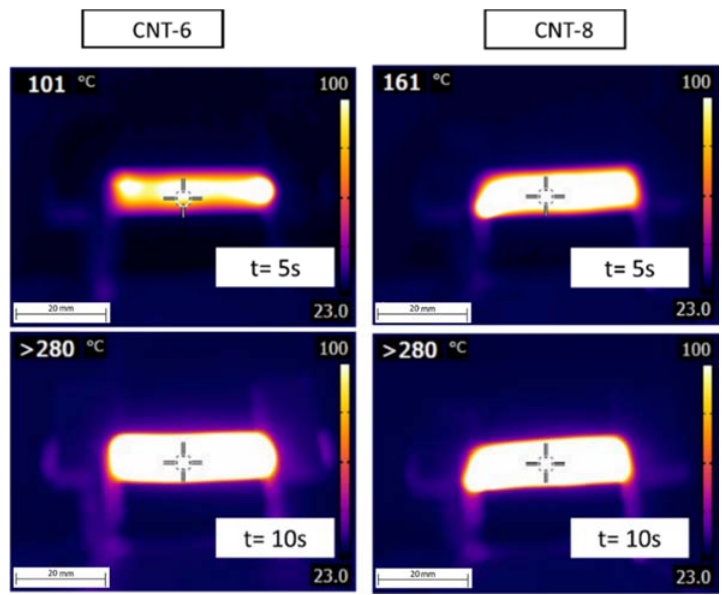
Figure 11. Infrared thermal imaging of CNT-6 ( left ) and CNT-8 ( right ) nanocomposites samples under an applied voltage of 24 V.